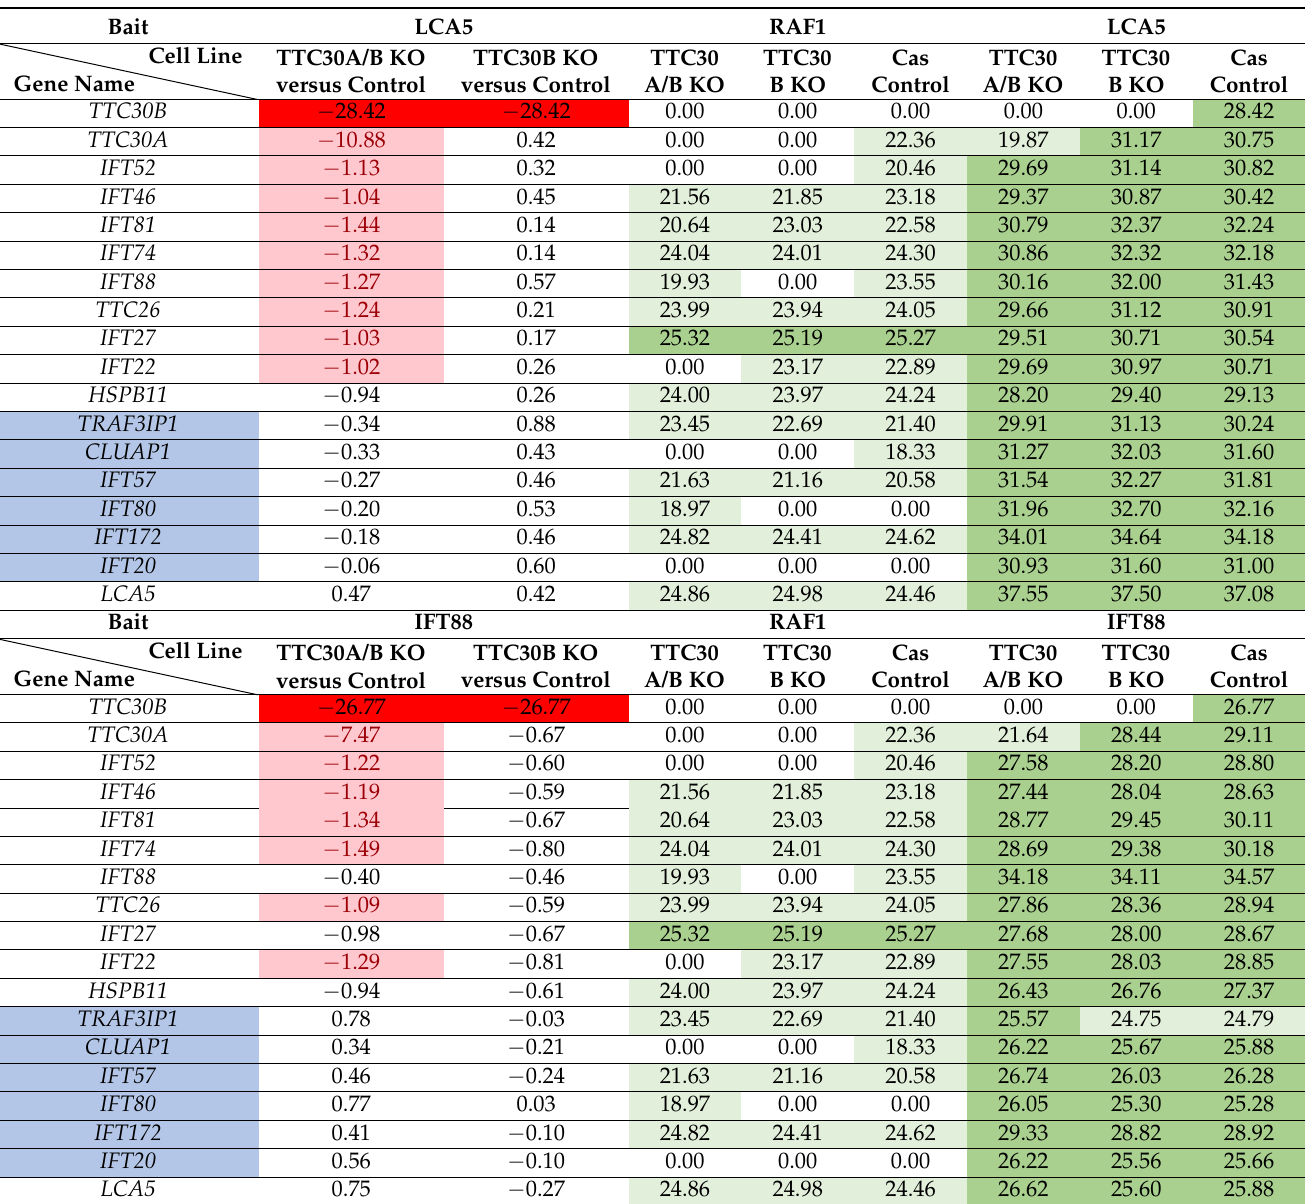
Table 1. IFT-B1 protein binding was impaired in TTC30A/B double-KO cells. Strep-based affinity purification of overexpressed LCA5, IFT88 or RAF1 as control was performed in TTC30A/B KO, TTC30B KO and Cas9 control cells, respectively. Here, the log 2 median values of four biological replicates (six columns to the right) and the calculated ratio (two columns to the left) for all 16 IFT-B proteins and LCA5 are shown. All proteins shown were significantly enriched when compared to RAF1 except HSPB11 and TTC26, which did not pass the t-test, but are included for completeness (significance B < 0.05, students t -test p < 0.05). IFT-B2 proteins are depicted in blue. Values ranging between − 1 and − 30 are highlighted in red; +1 and +40 in